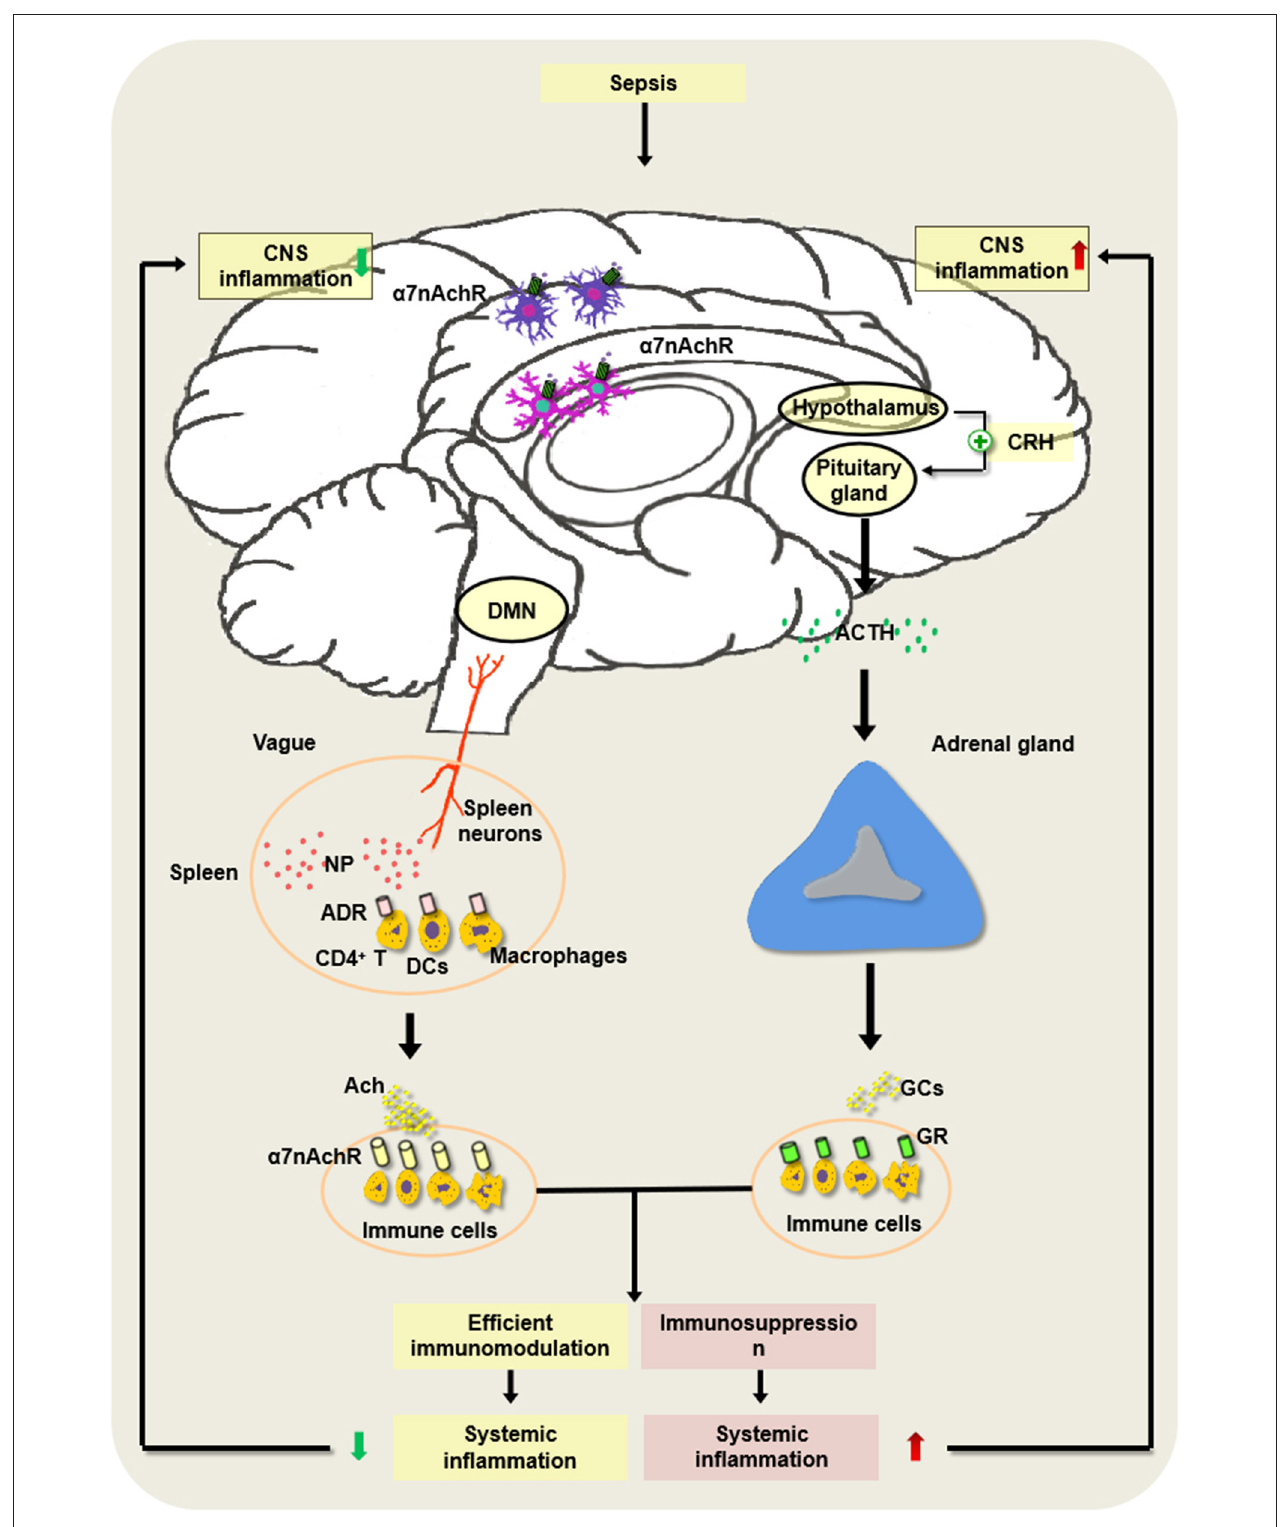
FIGURE 2 | Regulatory mechanism underlying hypothalamic–pituitary–adrenal (HPA) axis and cholinergic anti-inflammatory pathway (CAP) in the development of sepsis. In the pathogenesis of sepsis, the HPA axis is activated via the vagus nerve or the humoral pathway, and the hypothalamus and pituitary gland